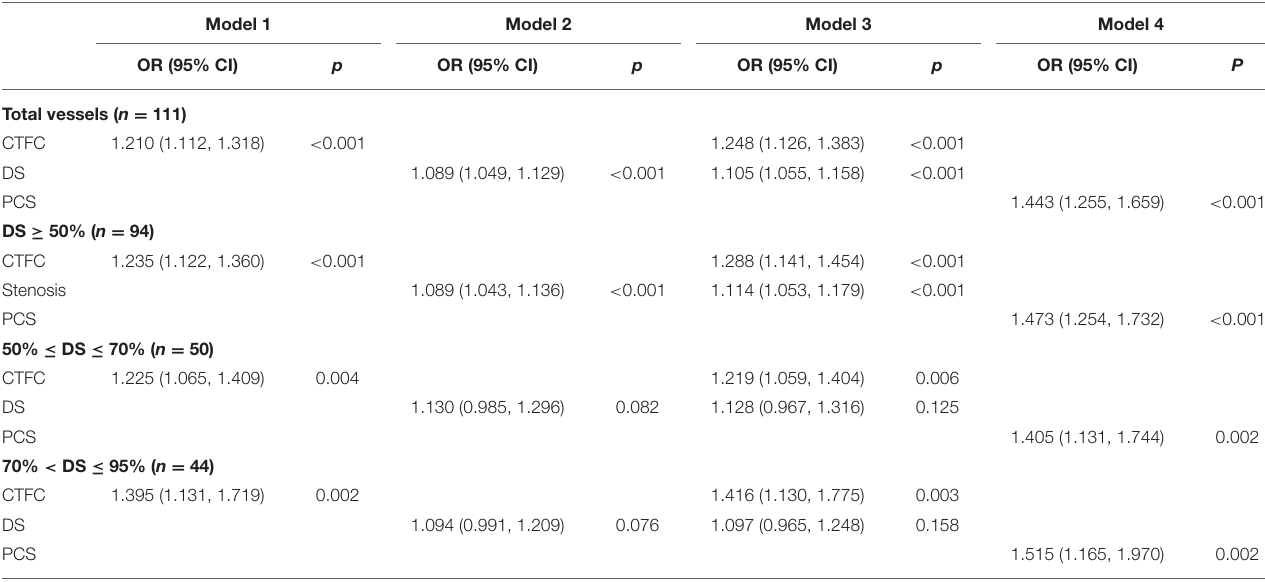
TABLE 4 | The results of binary logistic regression in coronary arteries with positive and negative FFR.